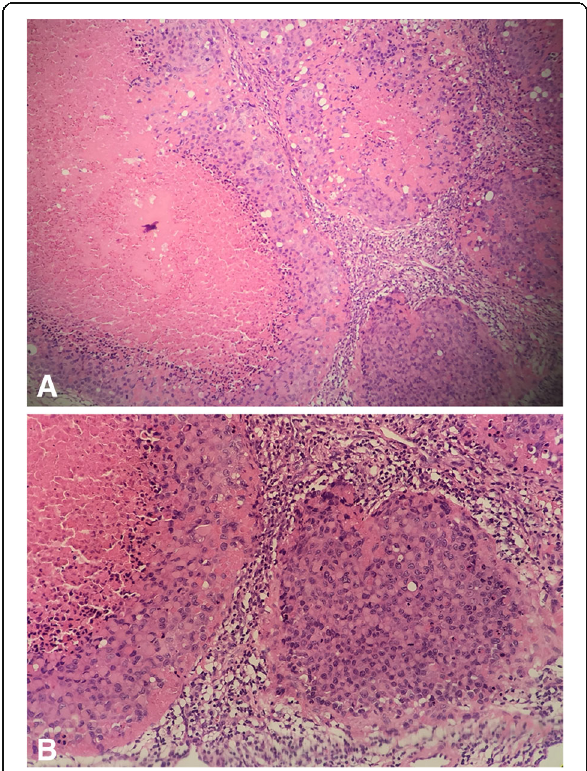
Fig. 4 Microscopic findings of the right axillary lymph nodes. H&E staining indicated a poorly differentiated carcinoma ( a × 100; b ×